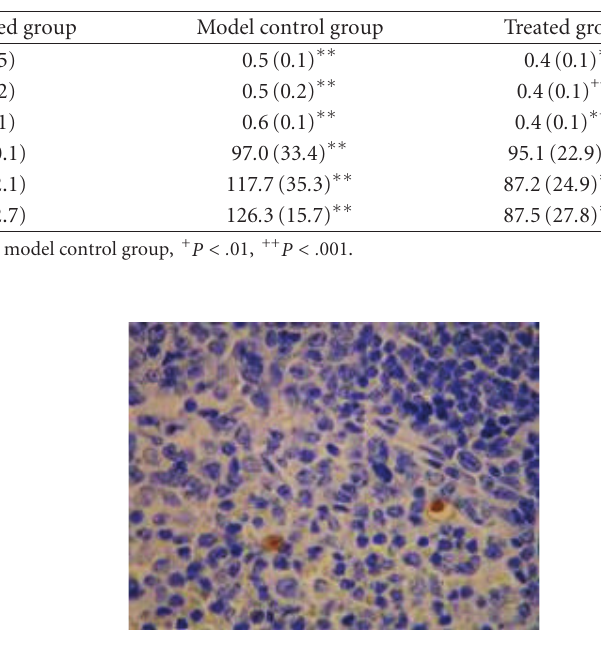
Table 1: Comparison of endotoxin and PLA 2 level of SAP groups ( M ( Q R )).